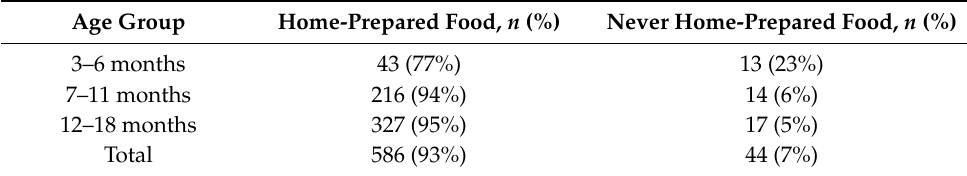
Table 3. Home-prepared feeding practices per age